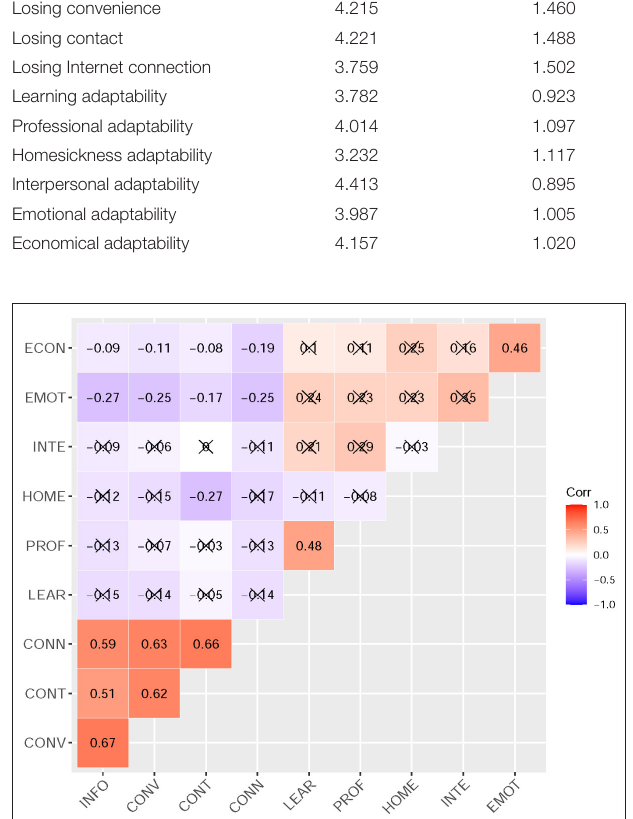
FIGURE 1 | Correlations between nomophobia with adaptability. INFO, unable to access information; CONV, losing convenience; CONT, losing contact; CONN, losing Internet connection; LEAR, learning adaptability; PROF, professional adaptability; HOME, homesickness adaptability; INTE, interpersonal adaptability; EMOT, emotional adaptability; ECON, economical adaptability.